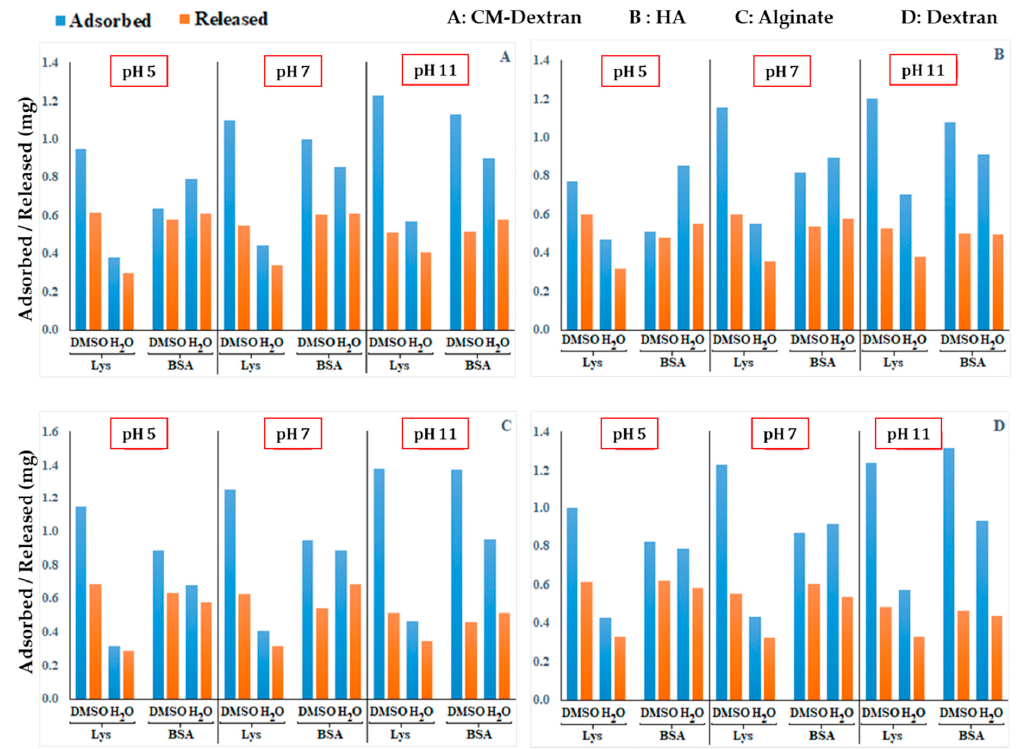
Figure 5. Adsorption (at 24 h—blue bar) and release (at 150 h—red bar) yields vs. pH 5, 7, and 11 for all 48 samples in the combinatorial study for each combination of factors (levels) {protein (2), polysaccharide (4), CL protocol (2), pH (3)}. Four subfigures refer to: (A) CM-Dextran, (B) Hyaluronic Acid, (C) Alginate, (D) Dextran.